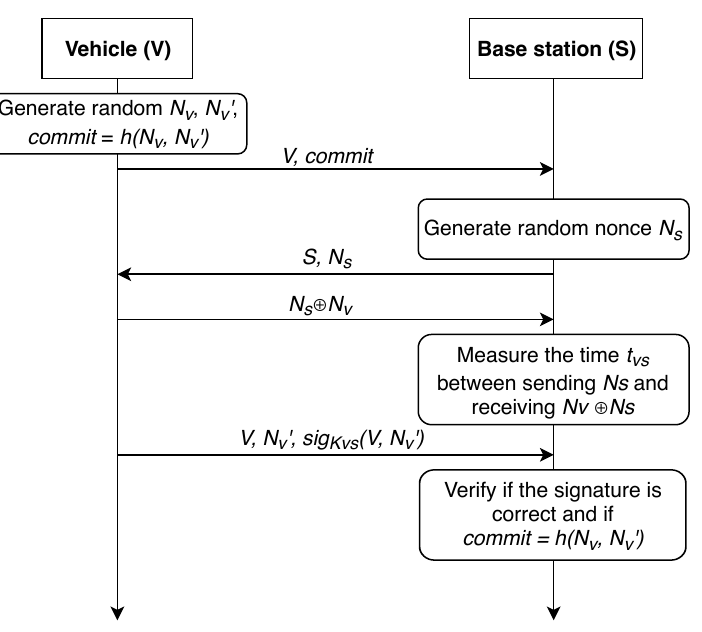
Figure 3. The distance-bounding protocol P-04